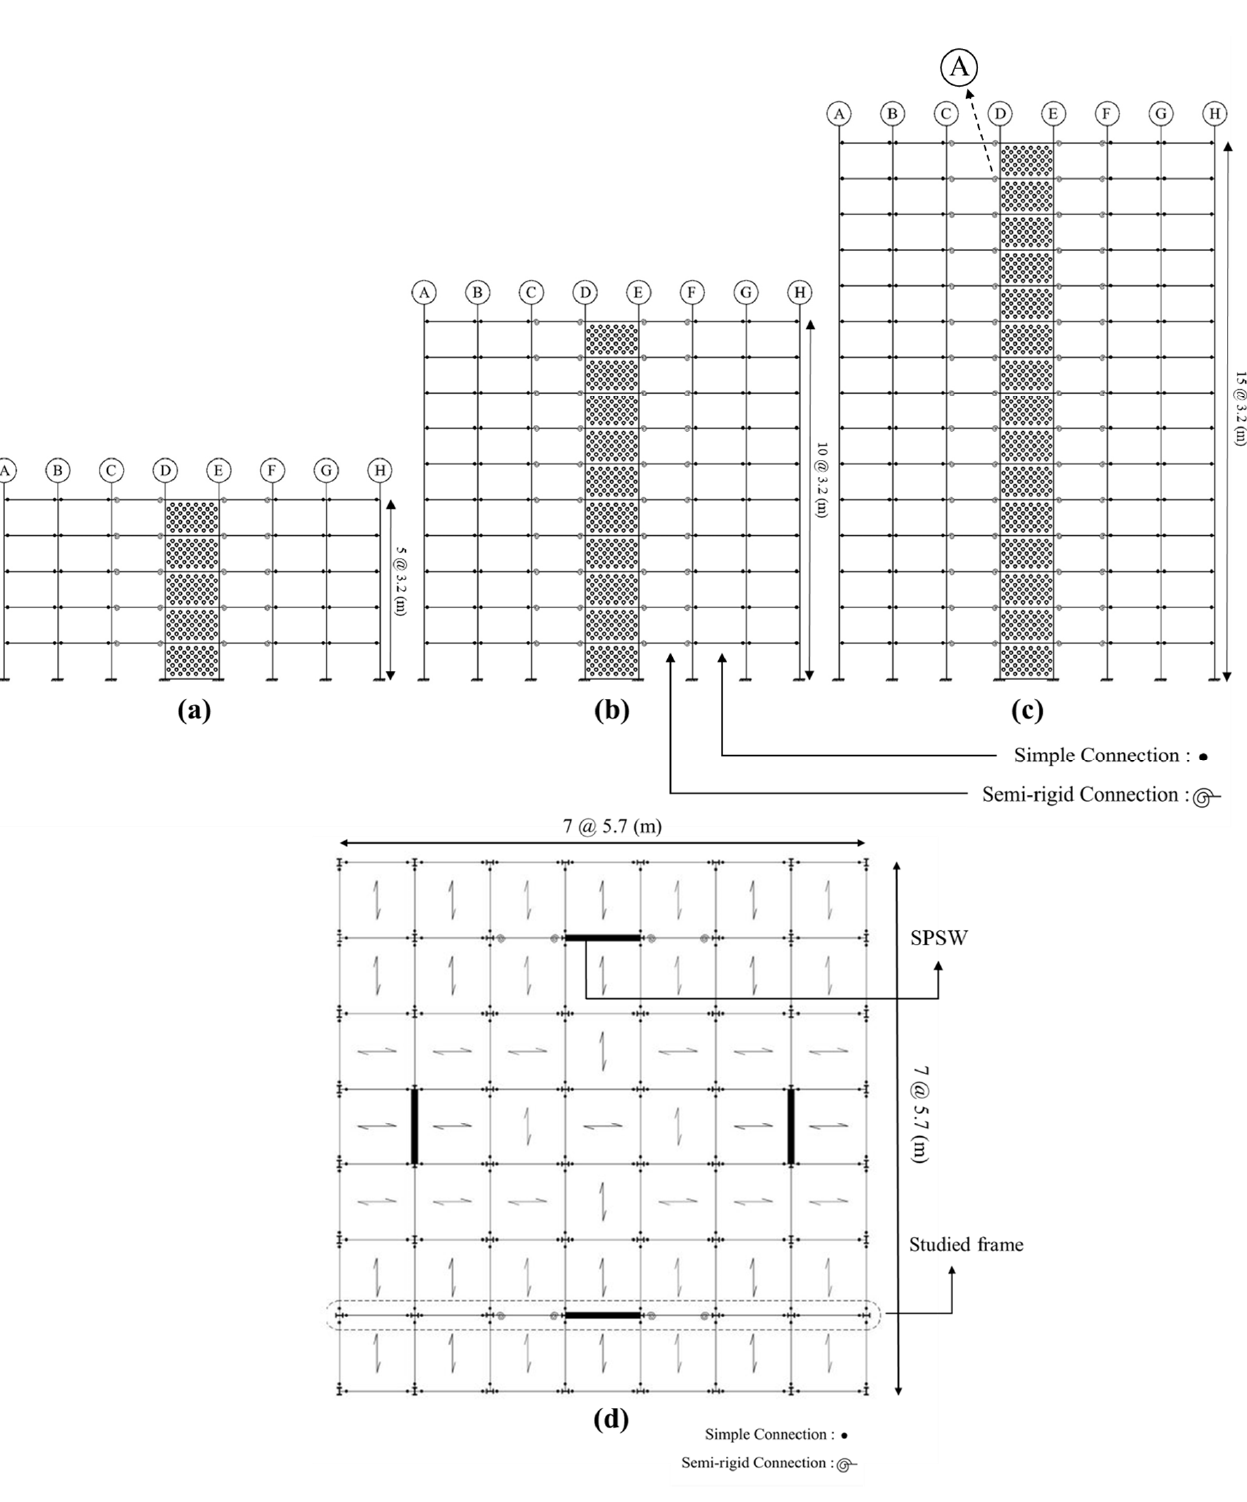
Figure 3. The modeled structures: ( a ) 5 stories; ( b ) 10 stories; ( c ) 15 stories; ( d ) Table 1. Beam, column and steel plate sections at different stories.